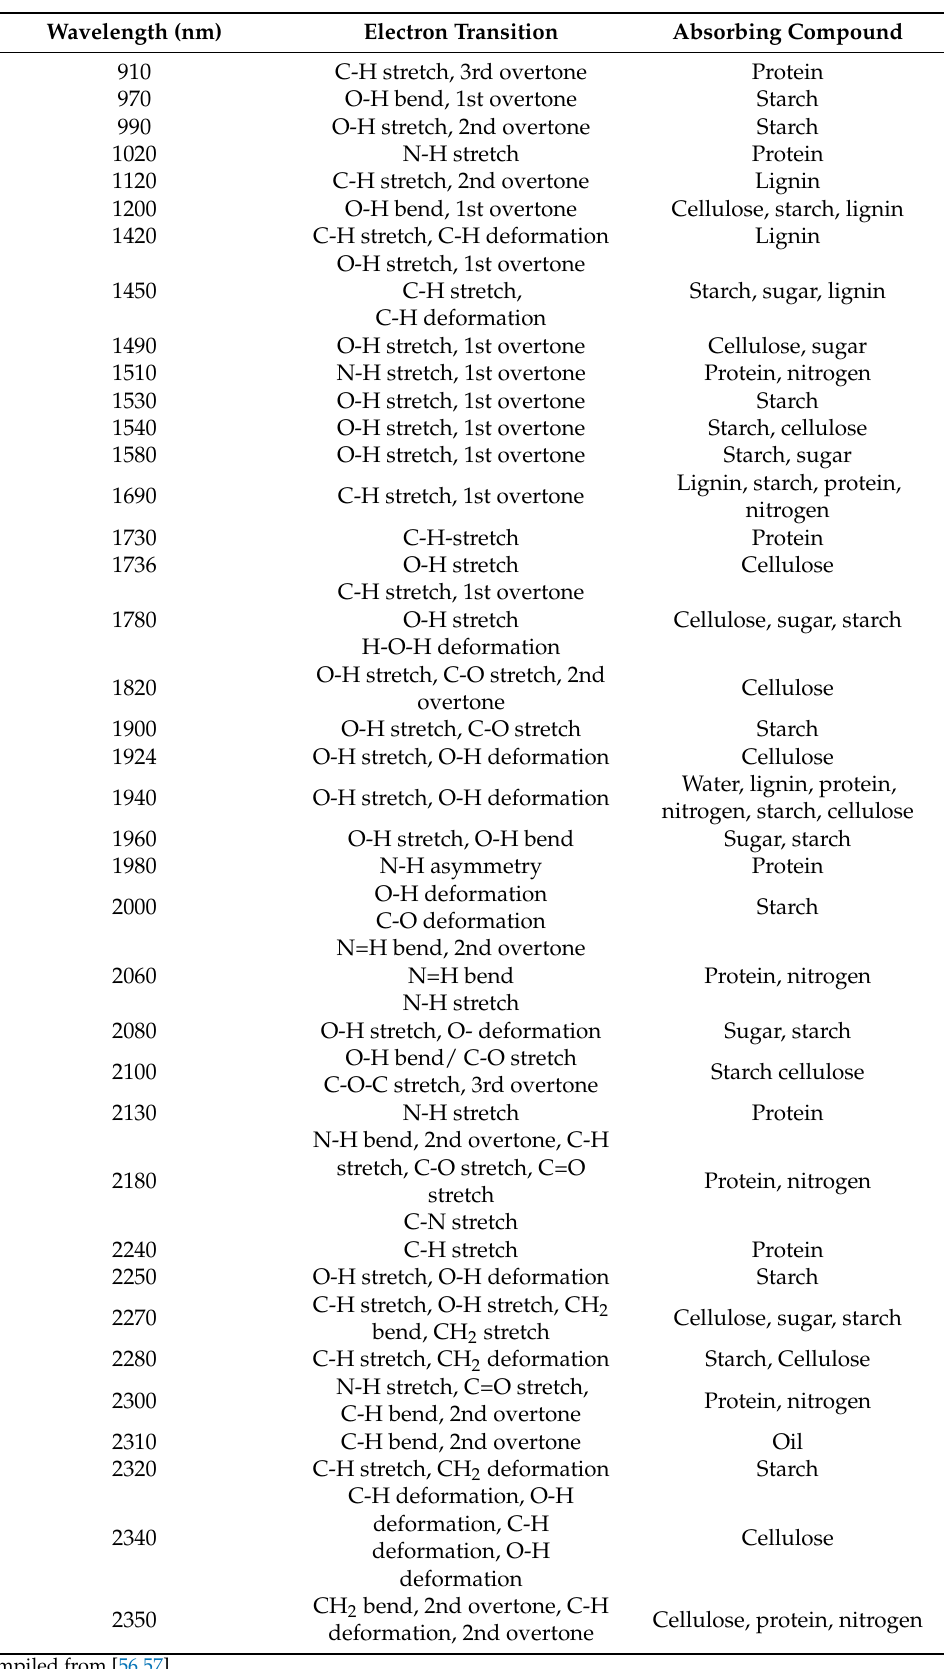
Table 1. Absorption features linked to compounds that constitute